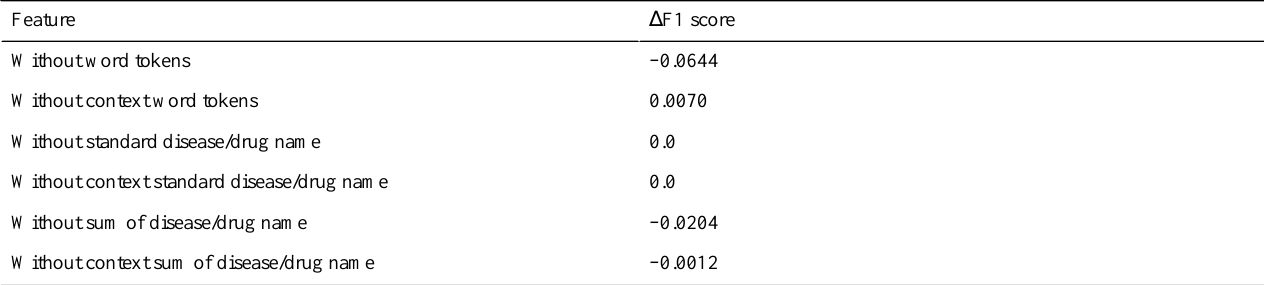
Table 4. Effects of each feature in adverse drug event–suggesting sentence